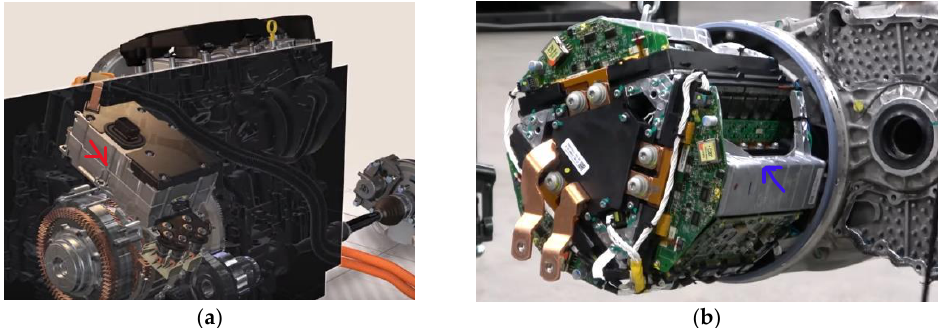
Figure 10. Motor and power electronics integration in recent vehicles; ( a ) 2016 Chevy Volt radially mounted drive (red arrow) [50] ( b ) Tesla Model S triangular frame axial endplate mounted electronic drive (blue arrow) [14]. Machines 2020 , 8 , x FOR PEER REVIEW